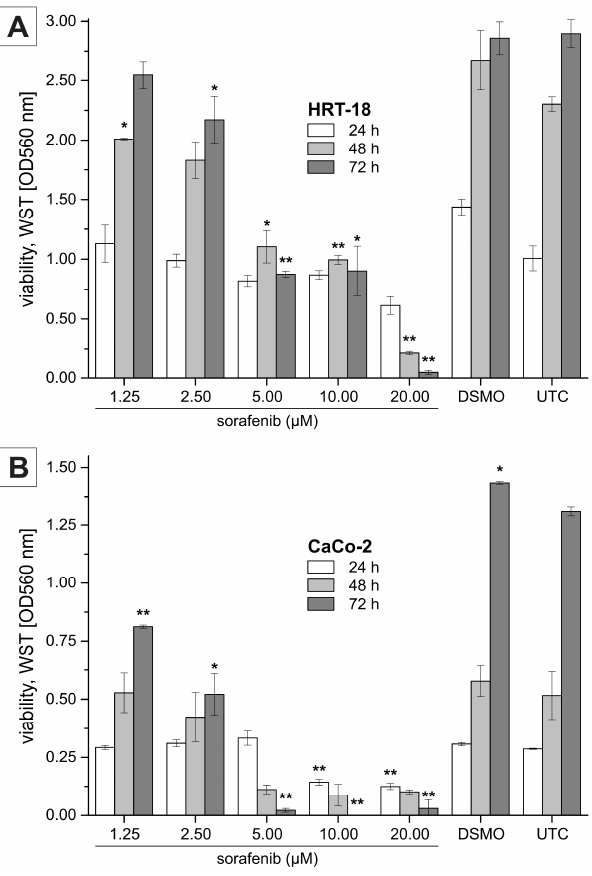
Figure 2. Dose- and time-dependent viability of ( A ) HRT-18 cells and ( B ) Caco-2 cells. Cells were seeded in 96-well microplates and treated with 1.25, 2.50, 5.00, 10.00 and 20.00 µM sorafenib. Viability was analyzed using WST-1 assay after 24, 48 and 72 h sorafenib treatment; data points represent mean values ± SEM of two independent experiments. ‘DMSO’ indicates samples treated with the solvent only (highest concentration). *, ** indicate values significantly ( p < 0.05) or highly significantly ( p < 0.01) different from the untreated control (UTC), respectively (two-sided, unpaired t -test).